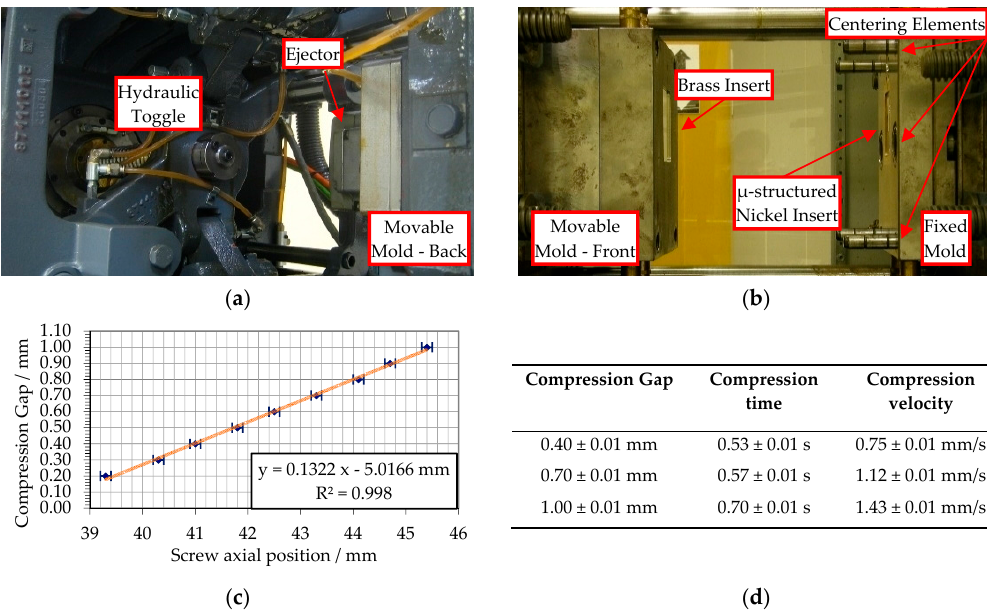
Figure 4. Injection compression molding solution: ( a ) toggle clamp unit with its hydraulic circuit; ( b ) movable (left) and fixed (right) mold plates in open configuration; ( c ) linear regression of the toggle unit position against the mold plates’ closure to control the compression gap; ( d ) summary table of the compression gap, compression time, and average compression velocity.